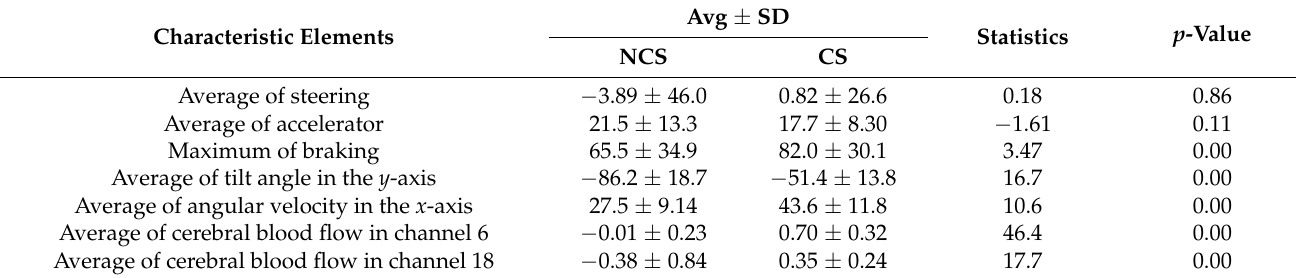
Table 7. Characteristics of behavior and cognition of older drivers when they feel impatient.